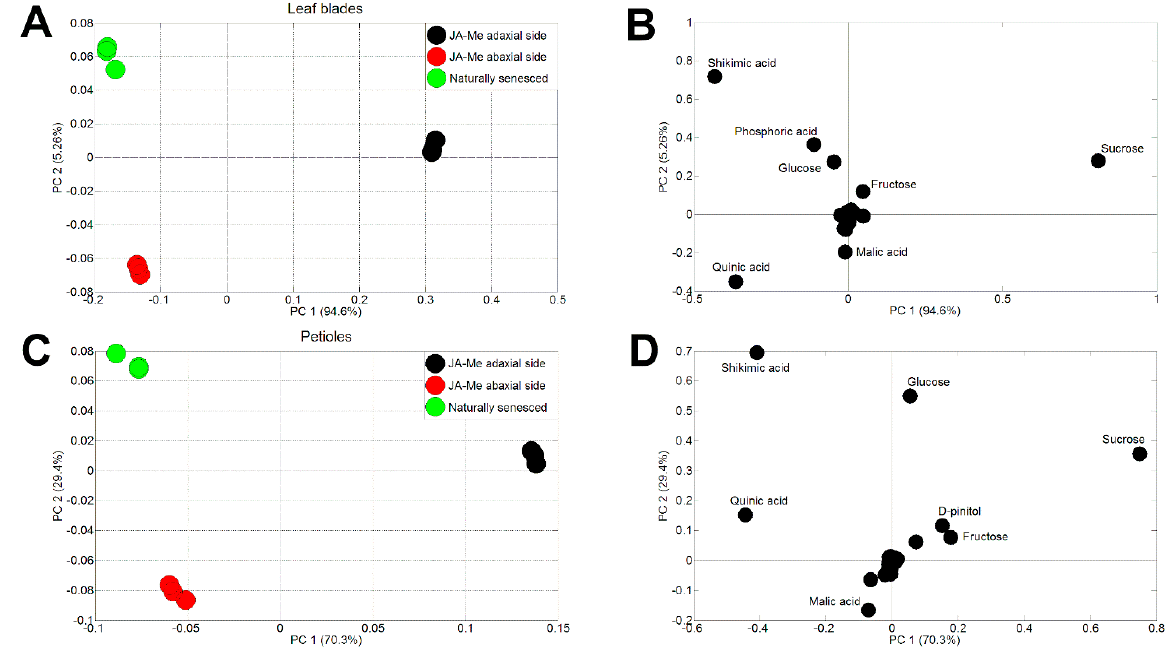
Figure 5. PCA scores ( A , C ) and loadings ( B , D ) of metabolic profiles of leaf blades and petioles of G. bilob a treated with methyl jasmonate (JA-Me) on the adaxial (black dots) and abaxial sides (red dots), as well as naturally senescent ones (green dots).